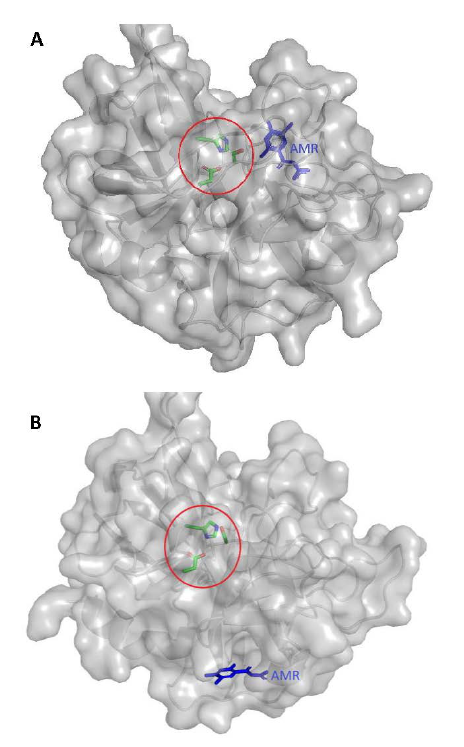
Fig. 1. A: uPA is shown as semitransparent surface, amiloride (dark blue) is docked in the specificity pocket, and amino acids of catalytic triad are shown as stick model, colored: green - carbon, blue - ni- trogen, red - oxygen in the red circle. B: tPA amiloride is docked in a distant site from the specificity